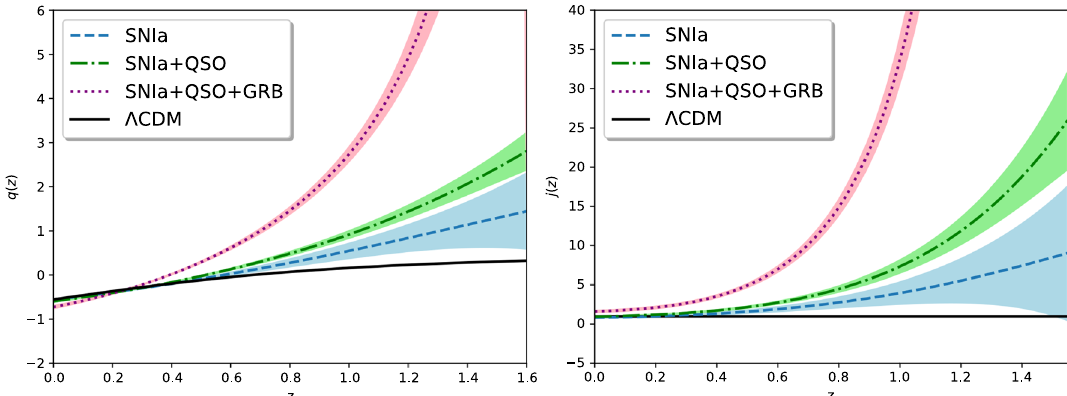
Fig. 6 Left panel: Reconstruction of q ( z ) using different data sets and considering the Gaussian kernel. Right panel: Reconstruction of j ( z ) . In the case of Λ CDM model we use Ω m 0 = 0 . 3 (see solid black